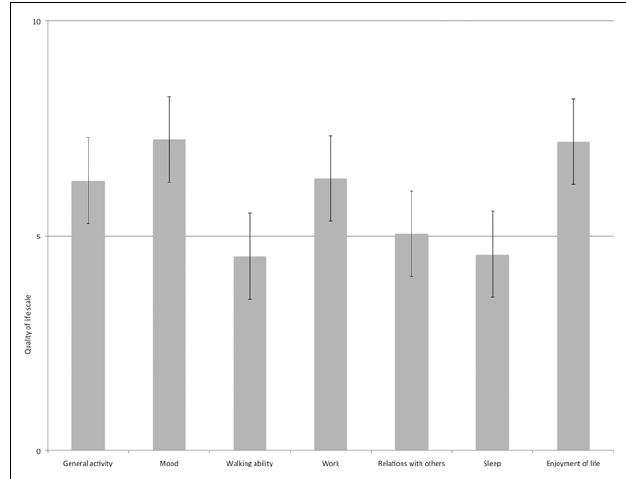
FIGURE 3 | Pain interference with general activity, mood, walking ability, work, social relations, sleep, and enjoyment of life in an 11-point scale of the Brief Pain Inventory (0 = “no interference” e 10 = “interferes completely”). The horizontal line defines the median point of the scale